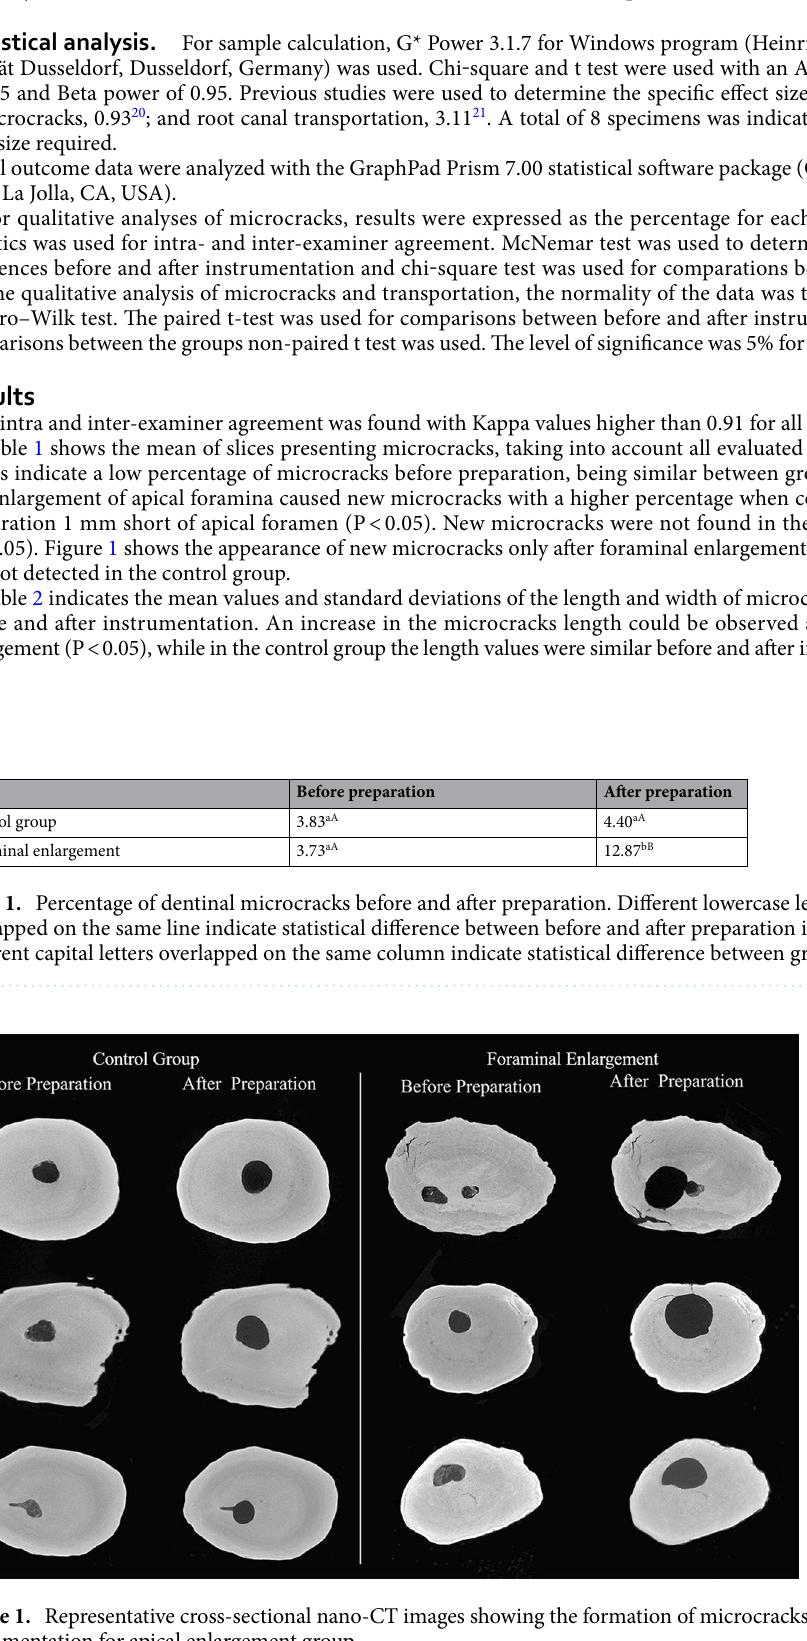
Figure 1. Representative cross-sectional nano-CT images showing the formation of microcracks after instrumentation for apical enlargement